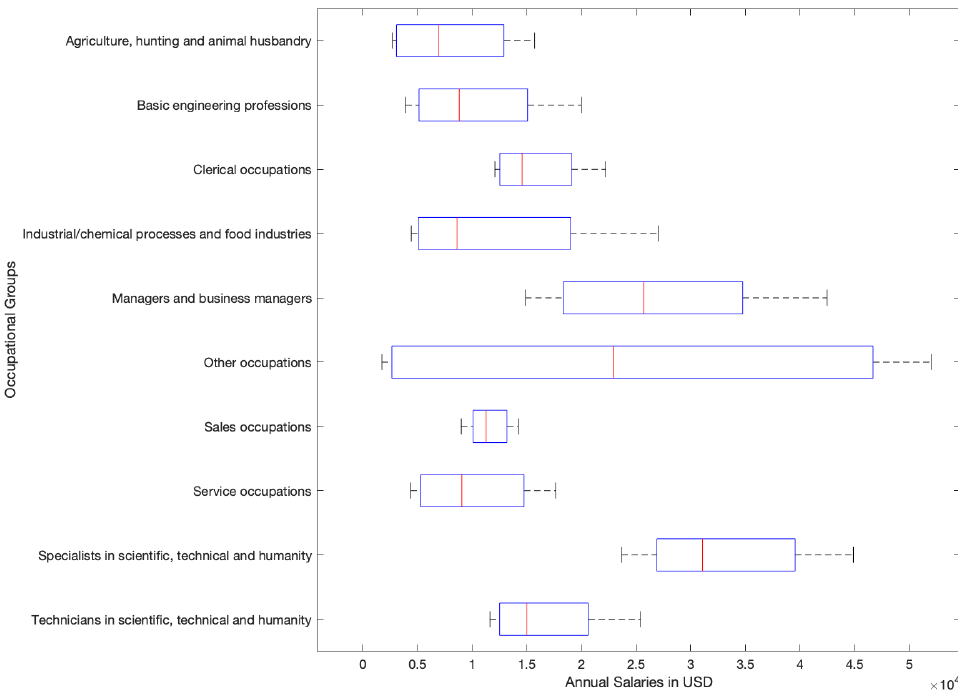
Figure 2. Box plot of mean annual salaries across major occupational groups